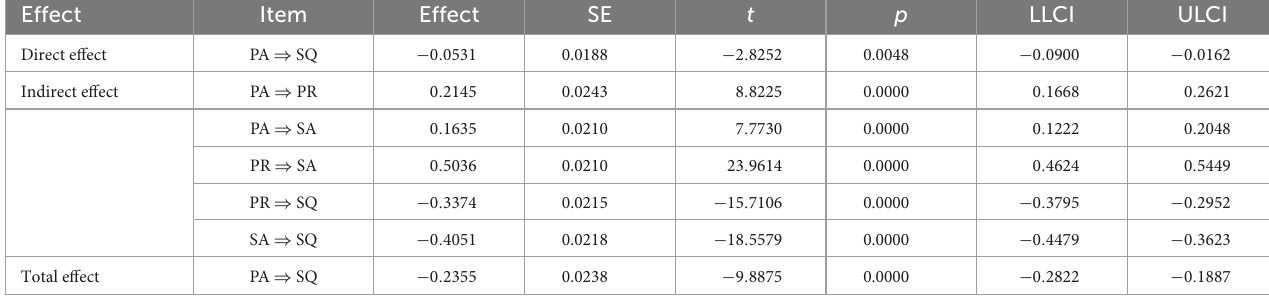
TABLE 3 Analysis of regression relationship among variables.